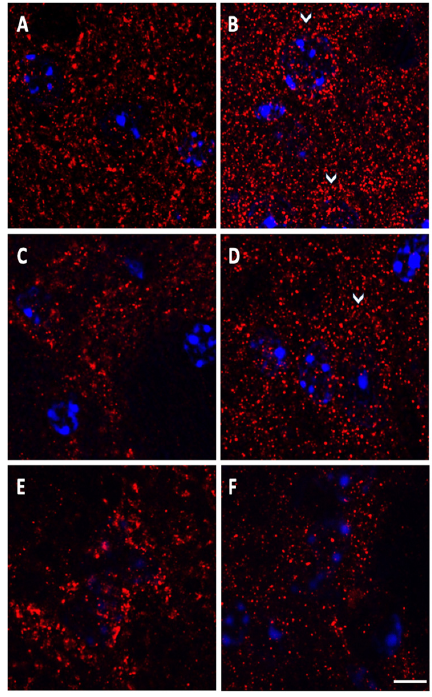
Figure 4. Representative immuno-fluorescence microphotographs of high magnification (63 × oil immersion objective plus zoom factor 1 × –1.5 × –2.5 × ) confocal laser scanning microscopy, showing the roundish morphology of A2A positive tiny spots and their distributions in the striatum ( A , B ), globus pallidus ( C , D ), and entopeduncular nucleus ( E , F ) of control Tor1a+/+ ( A,C,E ), and of mutant Tor1a +/ − ( B,D,F ) mice. A2A receptor labeling is visualized in red-Cy3 fluorescence, while cell nuclei are visualized by 4 ′ ,6–diamidino–2–phenylindole (DAPI) fluorescence in blue. White arrows in B and D point to clustering of A2A grains around neuronal bodies. Scale Bar in F = 5 µm.